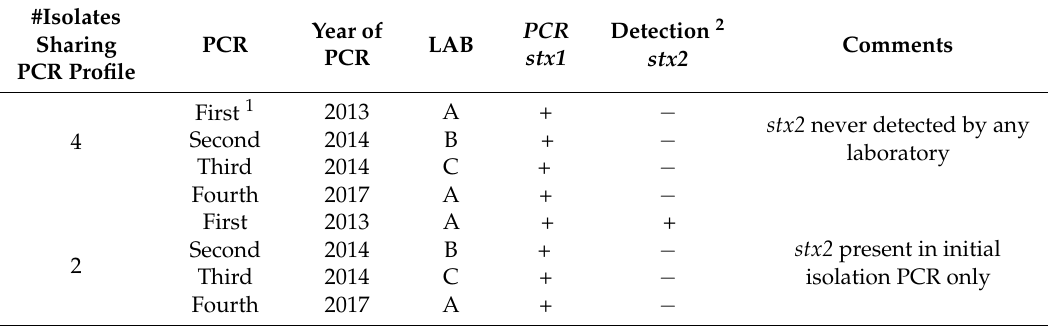
Table 6. Changes in carriage of stx2 and consistent detection of stx1 in six O111:H8/NM isolates from PCR analyses by three